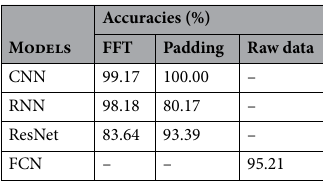
Table 4. accuracies of unsupported sleeper detection.